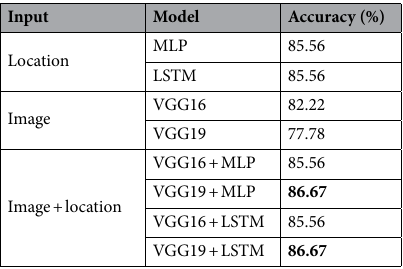
Table 11. Three-wound-class classification (D vs. P vs. A + V) on Medetec dataset. The bold represents the highest results/accuracy achieved for each experiment.